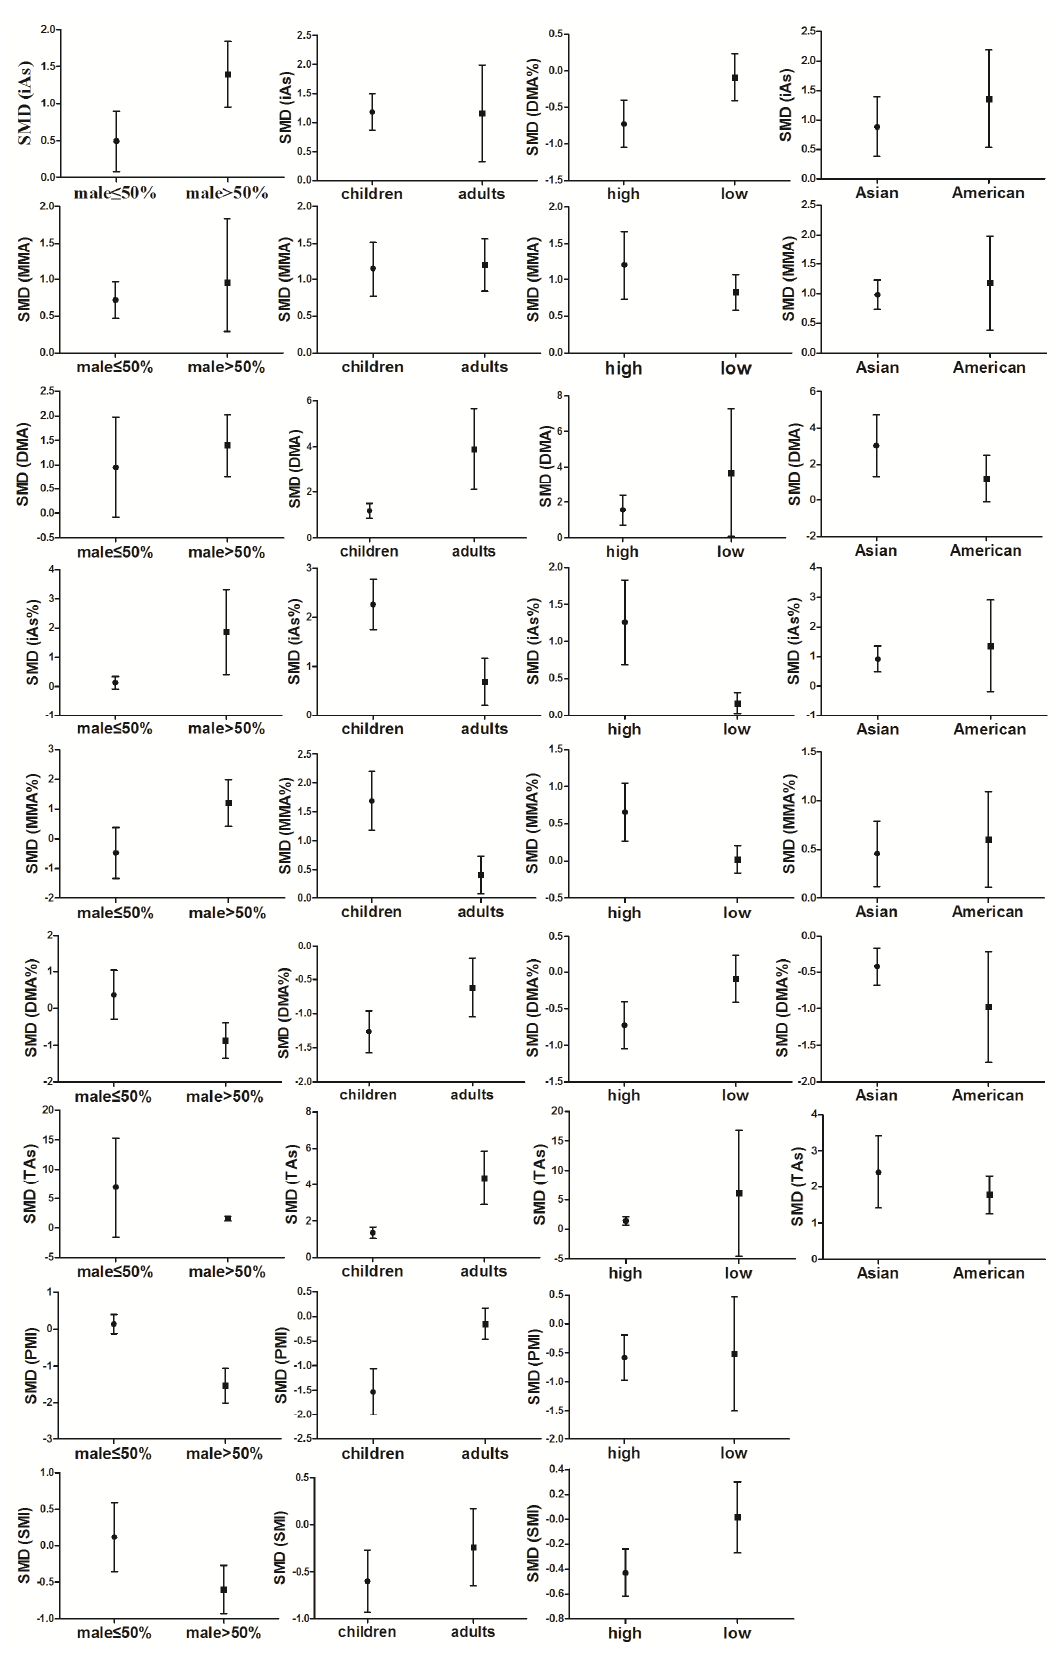
Figure 11. Results of the subgroup analyses of the effects of arsenic exposure (high vs. low). SMD, standardized mean difference; iAs, inorganic arsenic; MMA, monomethyl arsenic; DMA, dimethyl arsenic; iAs%, percentage of inorganic arsenic; MMA%, percentage of monomethyl arsenic; DMA%, percentage of dimethyl arsenic; TAs, total arsenic; PMI, primary methylation index; SMI, secondary methylation